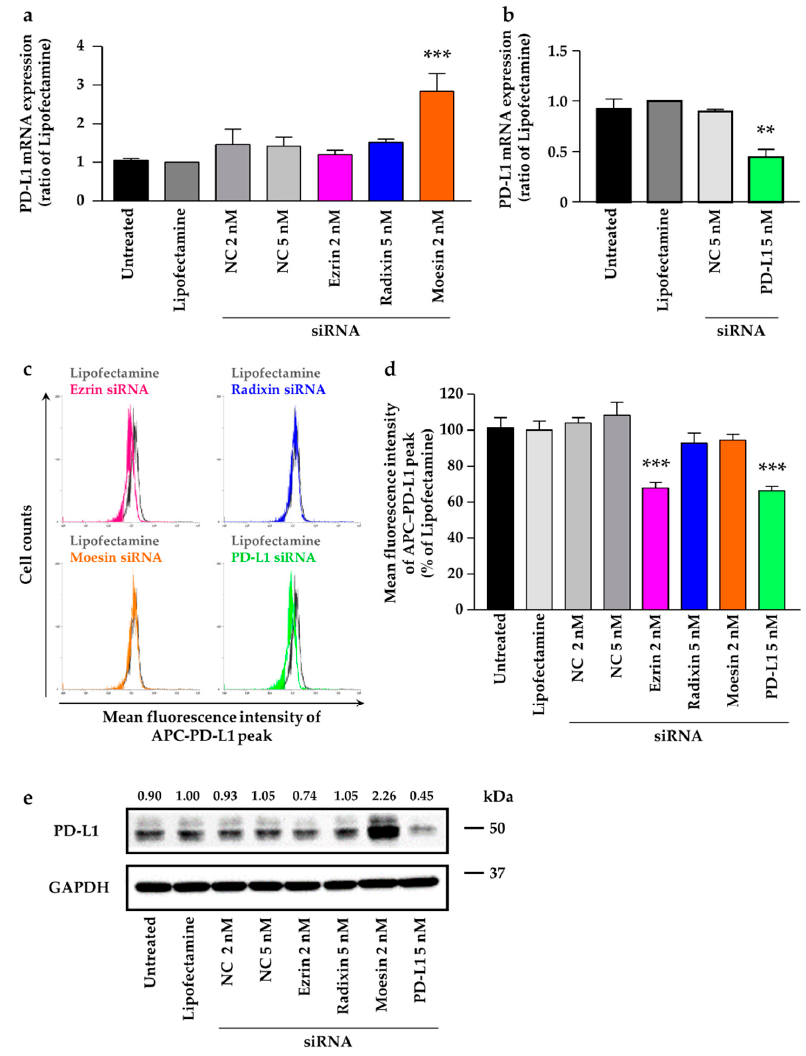
Figure 6. Effects of siRNAs targeting ezrin, radixin, moesin on total mRNA, total protein, and cell surface expression of programmed cell death ligand-1 (PD-L1) in HeLa cells. Cells were treated with the transfection medium (Untreated), transfection reagent (Lipofectamine), nontargeting control (NC) siRNA (2 nM and 5 nM), or specific siRNAs for ezrin (2 nM), radixin (5 nM), moesin (2 nM), or PD-L1 (5 nM) and then incubated for 3 days. The mRNA expression of PD-L1 in cells from all treatment groups was determined via quantitative reverse transcription-polymerase chain reaction. ( a ) n = 3–6, *** p < 0.001 vs. Lipofectamine, ( b ) n = 3, ** p < 0.01 vs. Lipofectamine. All data are expressed as mean ± SEM and were analyzed using a one-way ANOVA followed by Dunnett’s test. ( c ) An overlay of the representative histograms for the mean fluorescence intensity of allophycocyanin (APC)-labeled PD-L1 on the surface plasma membrane of HeLa cells treated with Lipofectamine (gray line), ezrin siRNA (red line), radixin siRNA (blue line), moesin siRNA (orange line), and PD-L1 siRNA (green line), as measured by flow cytometry. ( d ) The calculated mean fluorescence intensities of PD-L1 relative to Lipofectamine alone on the plasma membrane surface are shown for all the treatments; n = 6, *** p < 0.001 vs. Lipofectamine. All data were expressed as the mean ± SEM and analyzed by one-way ANOVA followed by Dunnett’s test. ( e ) Western blotting images of PD-L1 and glyceraldehyde-3-phosphate dehydrogenase (GAPDH) in whole-cell lysates of HeLa cells. Molecular weights are indicated in kDa. Ratio for the chemiluminescence signal intensity of PD-L1 normalized to GAPDH in each treatment group relative to Lipofectamine is shown on the respective